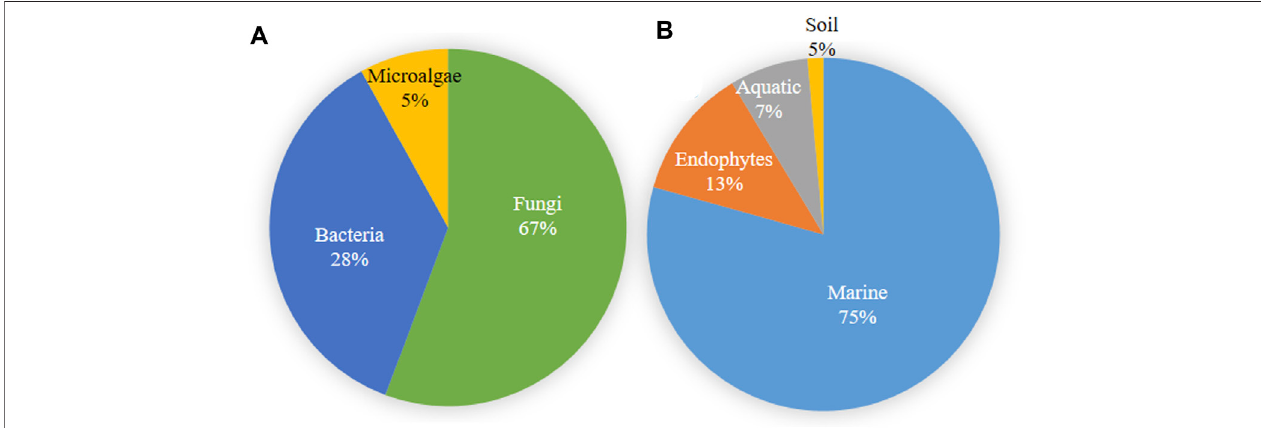
FIGURE 3 | Microbial source of antiviral compounds (A) and the source of microorganisms producing antiviral compounds (B) .